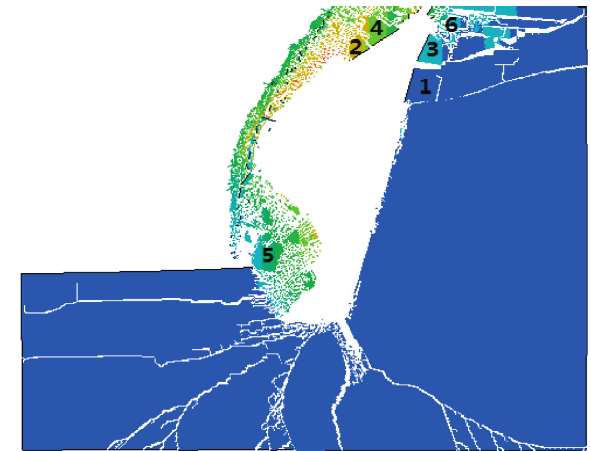
Figure 9: Distribution of rock